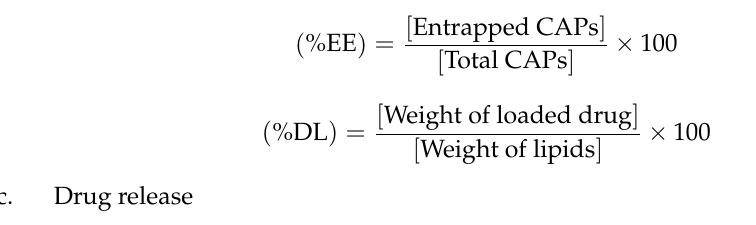
Table 1. Effect of lipid ratio on CAP-loaded nanoliposomes (particle size, PDI, Zeta potential, and %EE). Formula Mean Std. Minimum Maximum